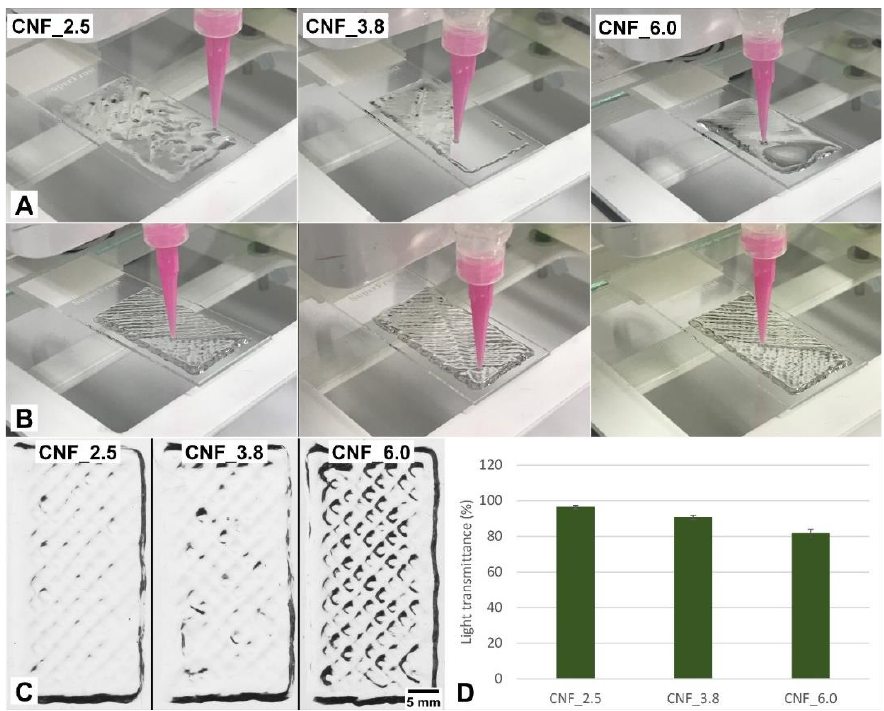
Figure 3. Three-dimensionally printable inks. ( A ) Exemplification of poor printability due to low CNF concentration (0.2 wt%). ( B ) Improved printability of 3D constructs with CNF at a concentration of 0.6 wt%. Left, middle, and right correspond to CNFs 2.5, 3.8, and 6.0 mmol, respectively. ( C ) Optical images of the 3D-printed constructs in four layers, CNF concentration = 0.6 wt%. ( D ) Quantification of light transmittance of 3D-printed constructs. Staples represent average and error bars; standard deviation, n = 4. The target dimensions of the 3D-printed constructs were 20 mm × 40 mm × 2